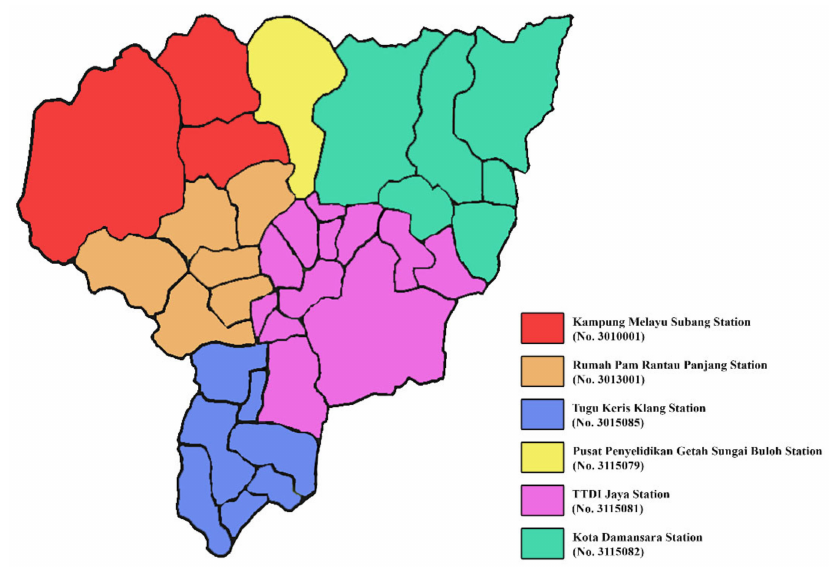
Figure A1. Assignment of rainfall input data to each